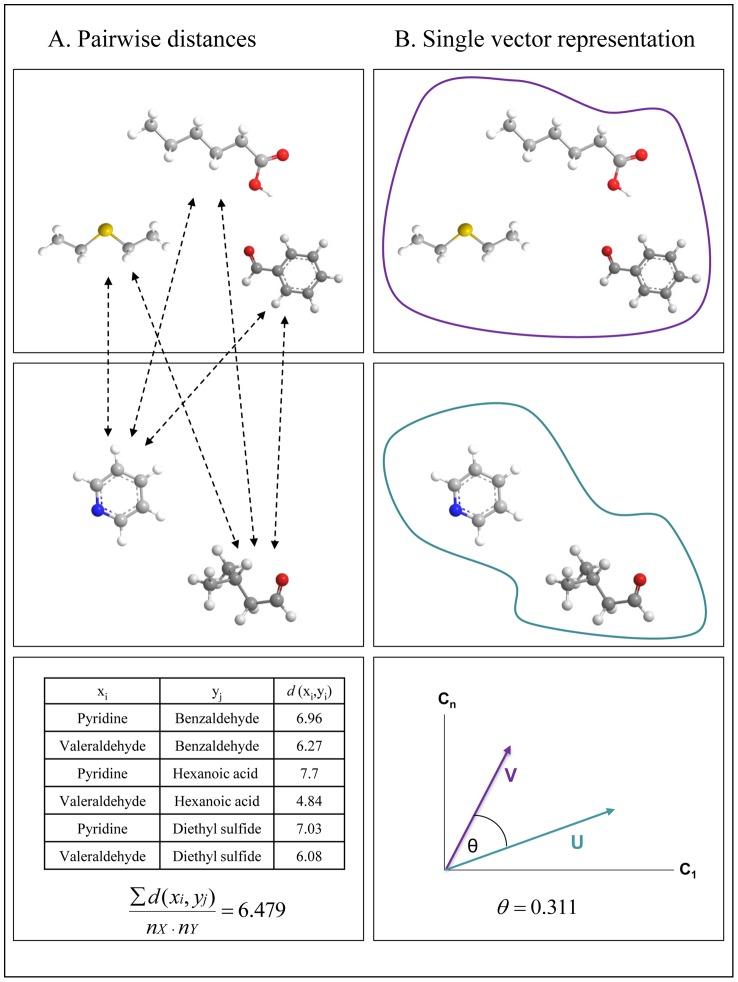
Modeling odorant mixtures as singular objects rather than component amalgamations.The top panels represent one mixture (Y) made of 3 mono-molecular components and the bottom panels represent a different mixture (X) made of 2 mono-molecular components. The distance between X and Y can be calculated as (A) The mean of all pairwise distances between all the components of X and Y. (B) Alternatively, one can represent both X and Y as single vectors reflecting the sum of their components, and define the distance between them as the angle between these two vectors within a physicochemical space of n dimensions.